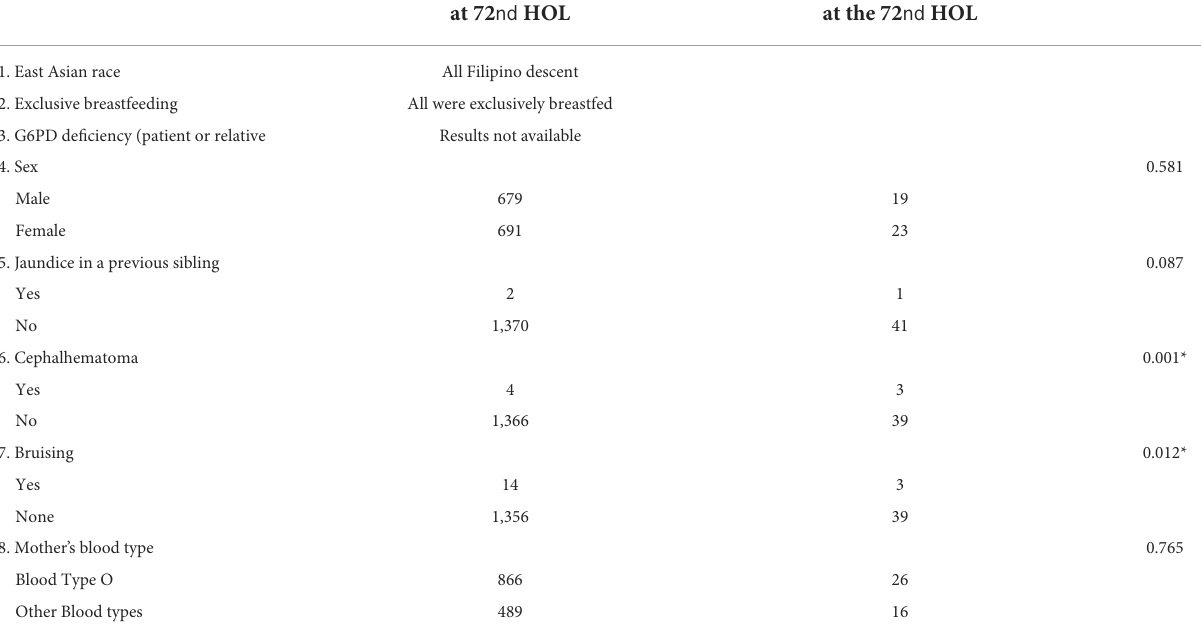
TABLE 4 Association of AAP guidelines’ risk factors and significant hyperbilirubinemia at 72nd